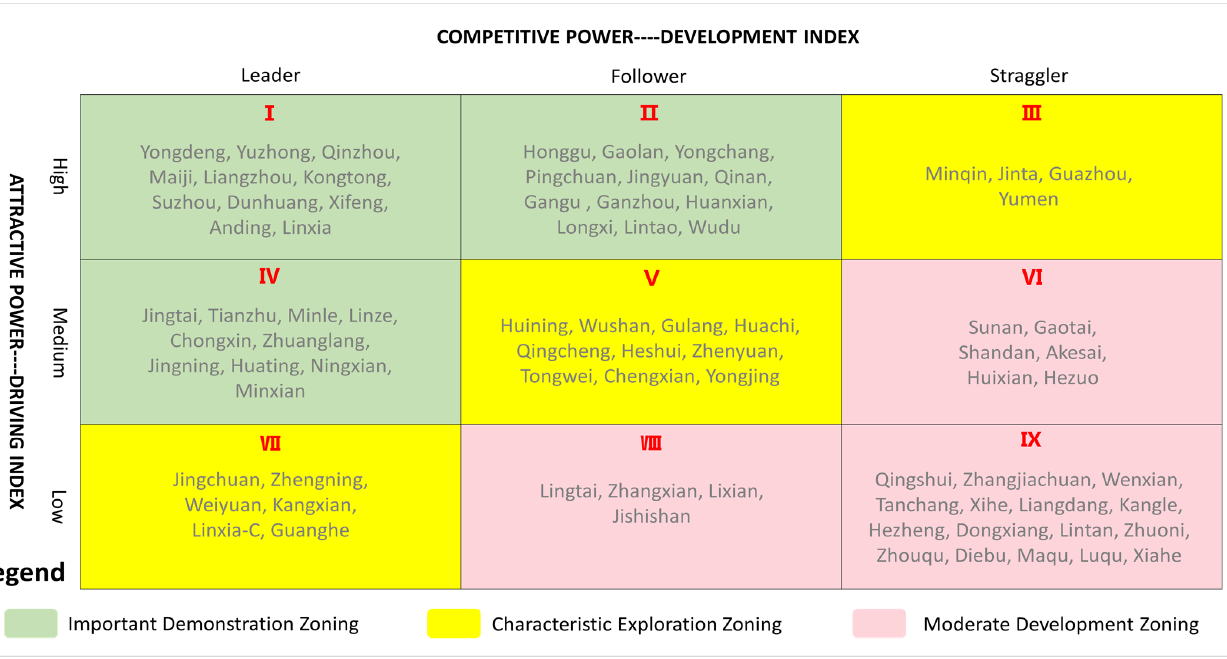
Figure 10. Analysis on spatial zoning of village economy digitalization in Gansu.